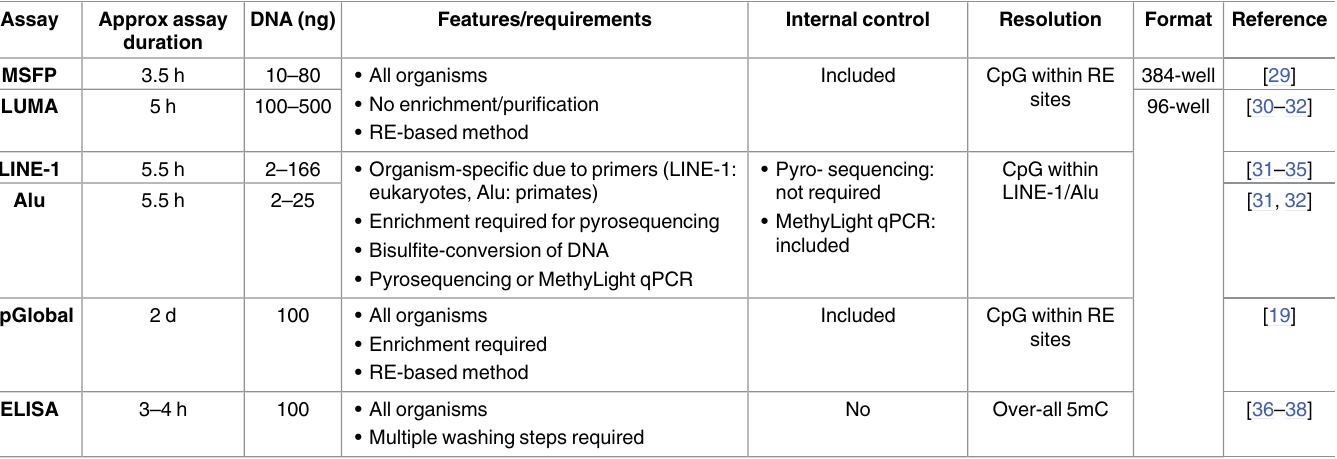
Table 1. Comparison of high-throughput global DNA methylation assays. DNA (ng)